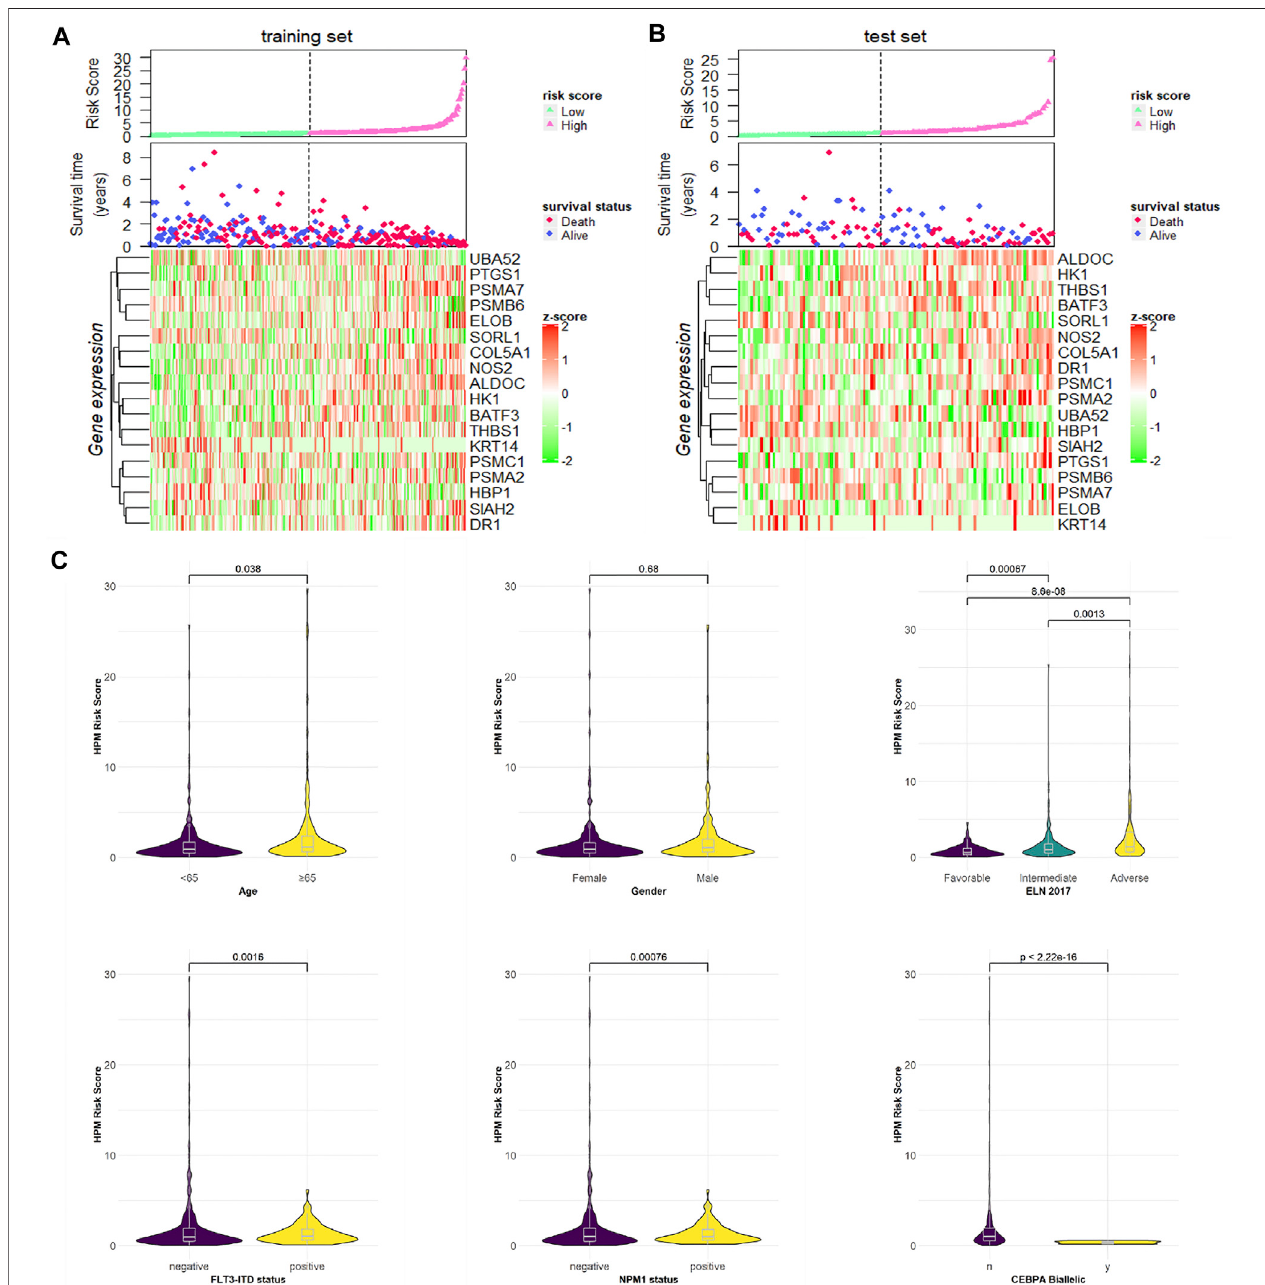
FIGURE 4 | Risk score distributions, genes expression, survival time, and status pro fi les in the (A) training and (B) test set. (C) Hypoxia risk score group by strati fi cation factors.